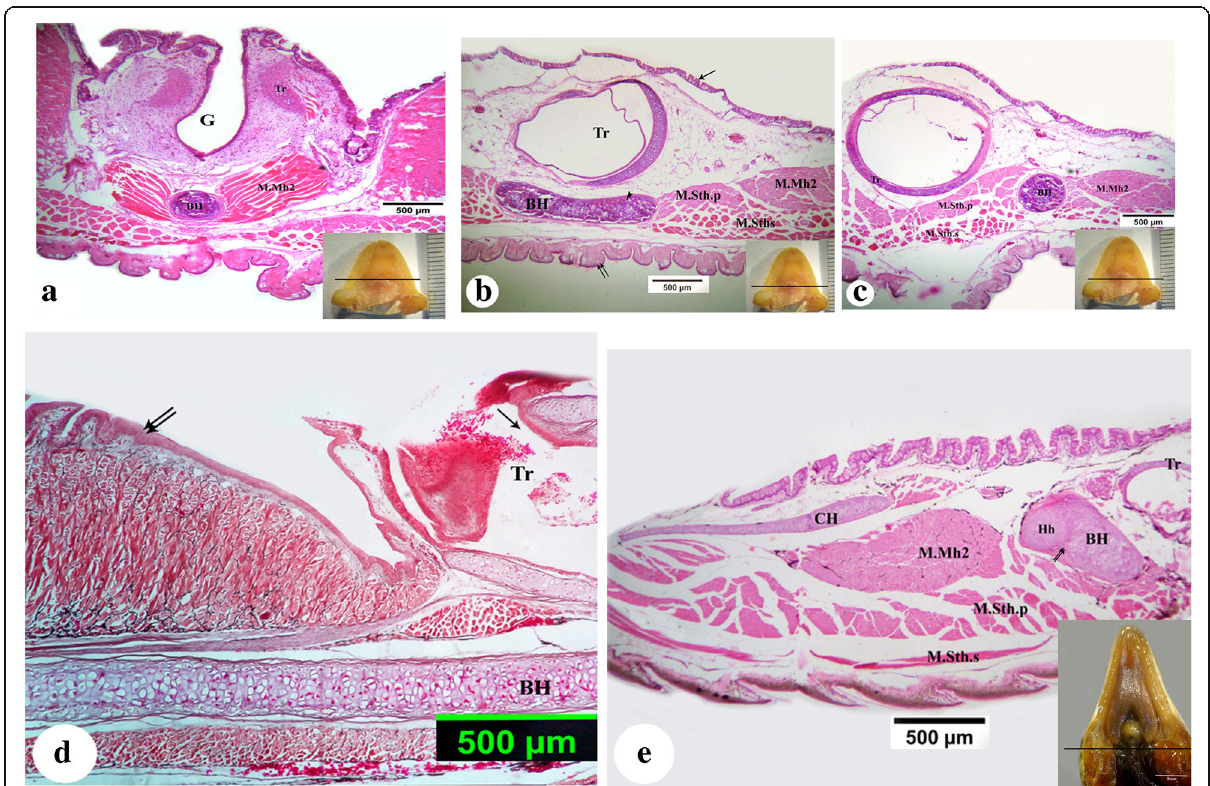
Fig. 3 a – c Photomicrograph of serial transverse section through the posterior portion of the tongue of P. guttatus showing the basihyoid (BH) and the appearance of calcium in matrix of hyaline cartilage of basihyoid (arrowhead), mandibulohyoideus 2 muscle (M.mh2), sternohyoideus profundous muscle (M.Sth.p), sternohyoideus superficialis muscle (M.Sth.s), the dorsal epithelium (arrow), the ventral epithelium (double arrows), glottis (G), and trachea (Tr). d Photomicrograph of longitudinal section through the posterior portion of the tongue of A. boskianus showing the position of basihyoid (BH), dorsal epithelium (double arrows), and glottis (arrow). e Photomicrograph of transverse section through the most posterior portion of the tongue of A. boskianus showing the insertion sites of the mandibulohyoideus 2 muscle (M.mh2), sternohyoideus profundous muscle (M.Sth.p), and sternohyoideus superficialis muscle (M.Sth.s) on basihyoid (BH), hypohyalis (Hh), ceratohyalis (CH), and articulation between basihyoid and hypohyalis (double arrows). a , b , c , e Stain by H&E. d Stain by Masson ’ s trichromic stain. Scale bar 500 μ